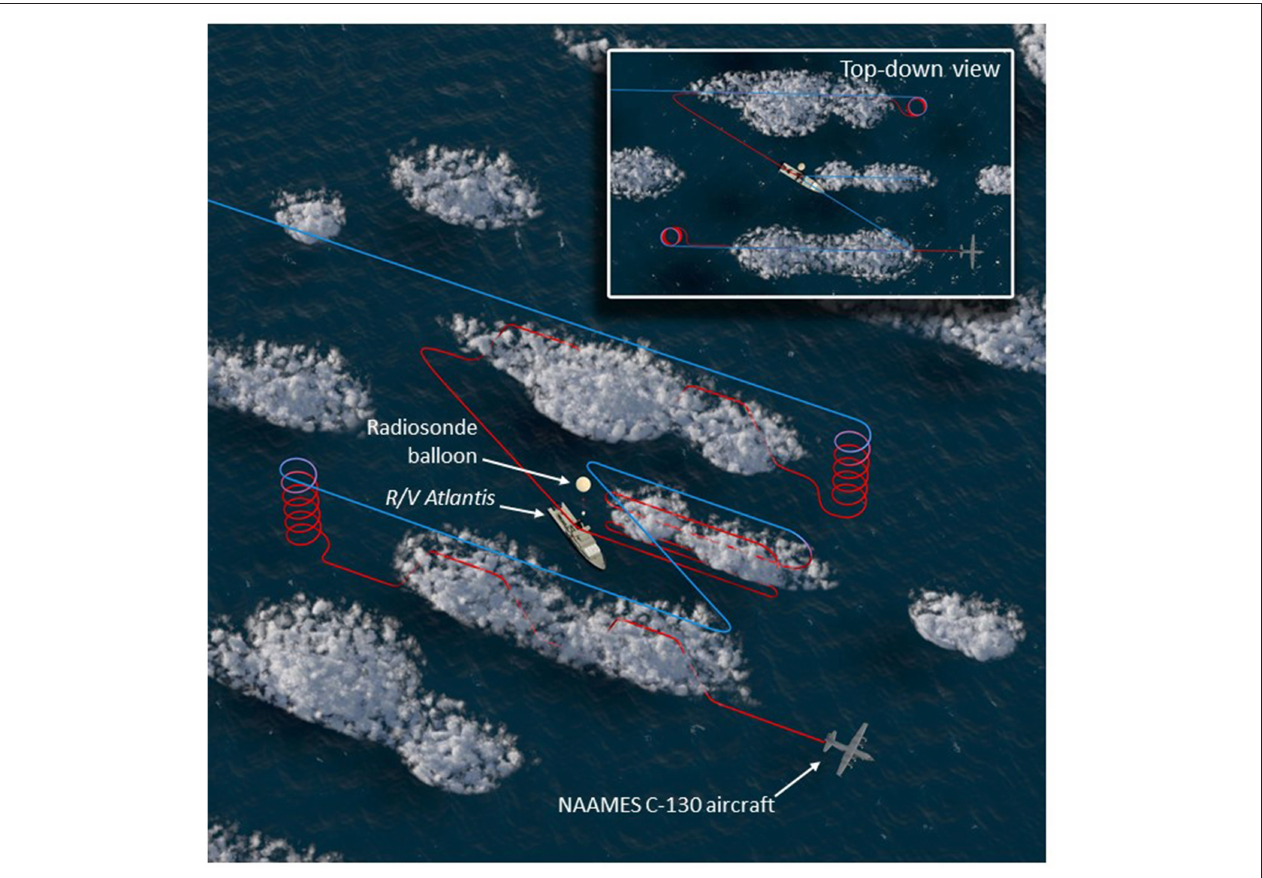
FIGURE 5 | Nominal NAAMES aircraft sampling pattern. High-altitude, remote sensing legs ( ∼ 6km) are colored blue, while lower-level legs sampling below, in, and above clouds are colored red. The R/V Atlantis is shown at the center of the pattern near the left-most edge of the cloud module, while a radiosonde balloon is visible in the scene. The inset, top-down view shows the similarity of the flight pattern to the letter “Z,” when viewed from